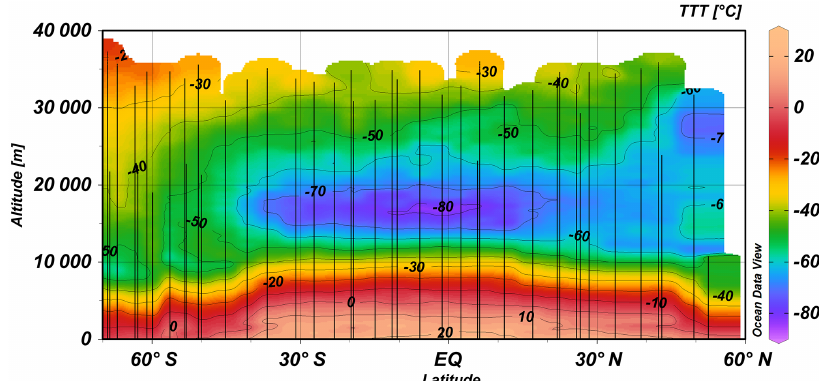
Figure 6. Meridional-height section of air temperature (TTT in ◦ C) from POLARSTERN cruise ANT-XVII (14 December 1999 to 20 Jan- uary 2000). The lines represent the actual launches, the data were then interpolated to obtain this figure.